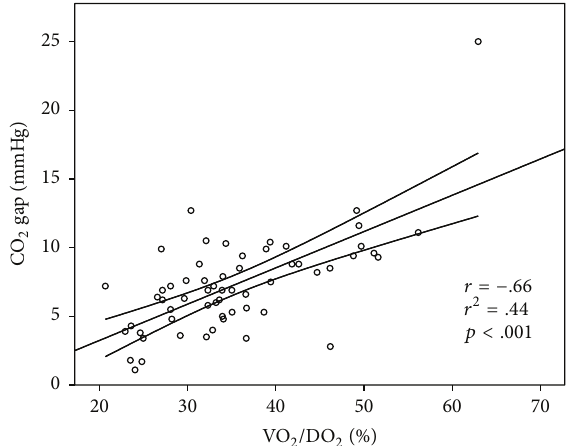
Table 3: Complementation of ScvO